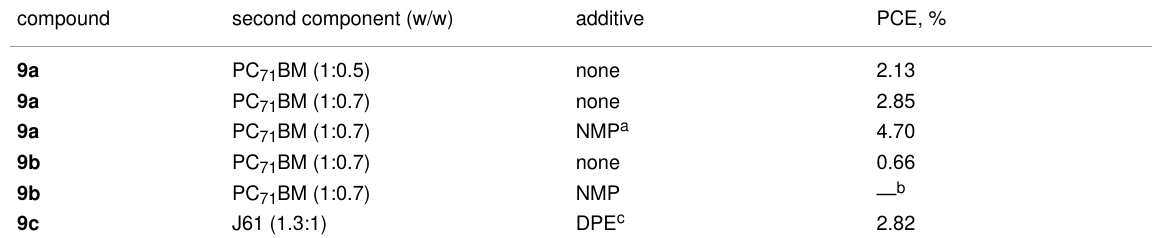
Table 1: Processing conditions and additive influence on OSC performance based on monoisoindigos 9a – c .